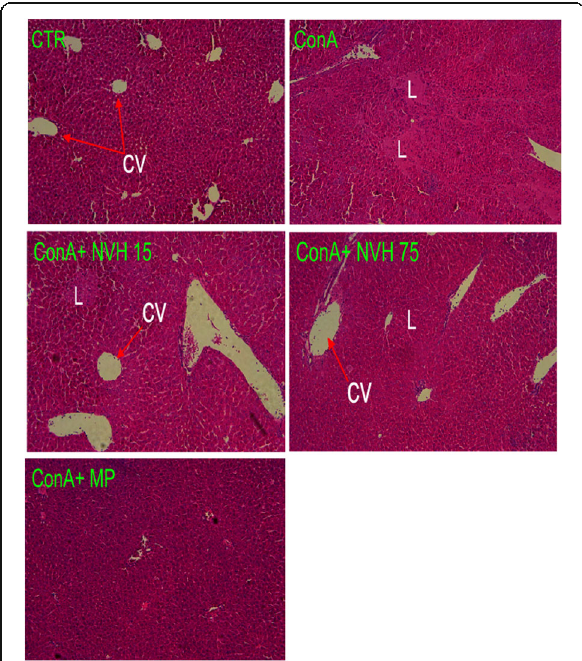
Fig. 11 Histological changes in Concanavalin A-intoxicated mice. Animals were pretreated with either NVH extract or methylprednisolone during 3 consecutive days and acute liver injury was immediately induced with Concanavalin A intravenous injection after the last treatment. All animals were sacrificed 8 h after Concanavalin A injection. Liver sections were fixed and paraffin-embedded before haematoxylin-eosin staining. CTR: Control mice with normal liver structure; ConA: Concanavalin A treated mice with a damaged liver; ConA+NVH (15 and 75): Concanavalin A and extract treated mice with some persistent necrotic areas; ConA+MP: Concanavalin A and methylprednisolone treated mice without lesions. NVH: Neoboutonia velutina aqueous extract; MP: Methylprednisolone; ConA: Concanavalin A; CV: centrilobular vein; L: necrotic area.